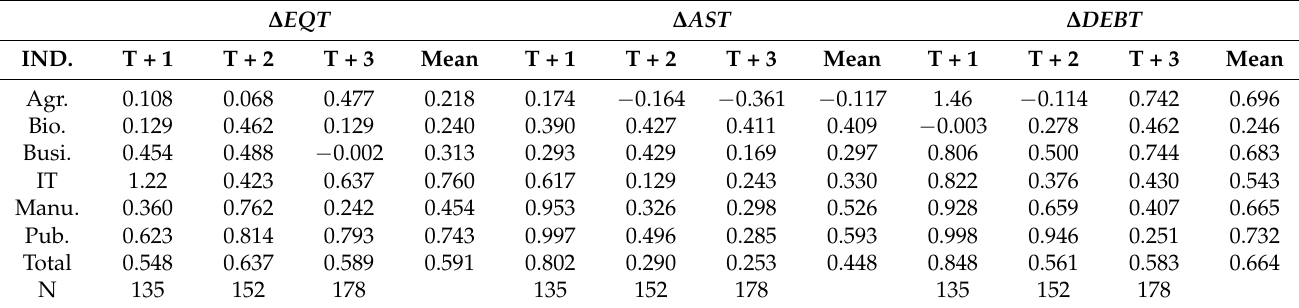
Table 3. Statistics of variations in EQT, AST, and DEBT in the three years after going